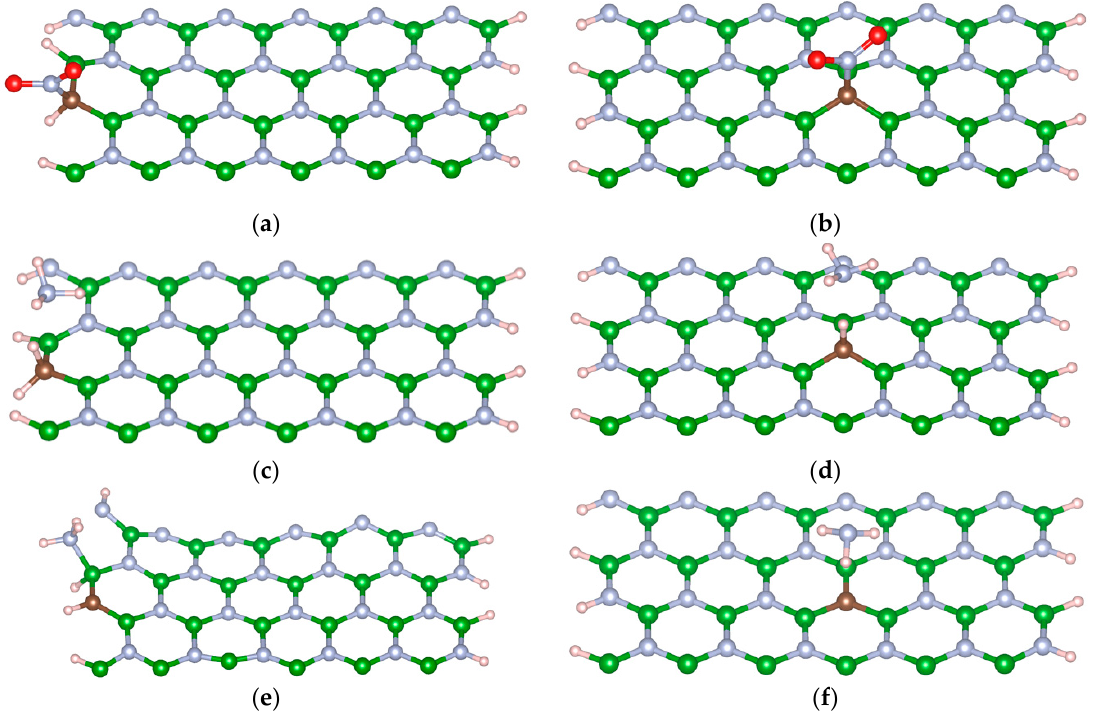
Figure 3. Schematic representation of the most stable interaction complex between M ‐ BNNR and toxic molecules: ( a ) NO 2 on the edge, ( b ) NO 2 at the center, ( c ) NH 4 on the edge, ( d ) NH 4 at the center, ( e ) NH 3 on the edge, and ( f ) NH 3 at the center.